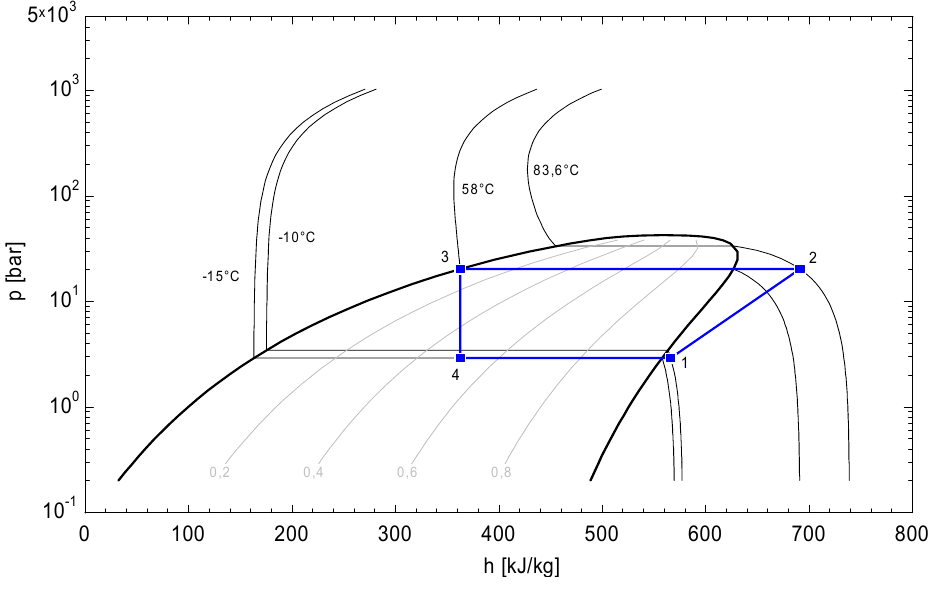
Figure 4. P-h diagram for the design point.